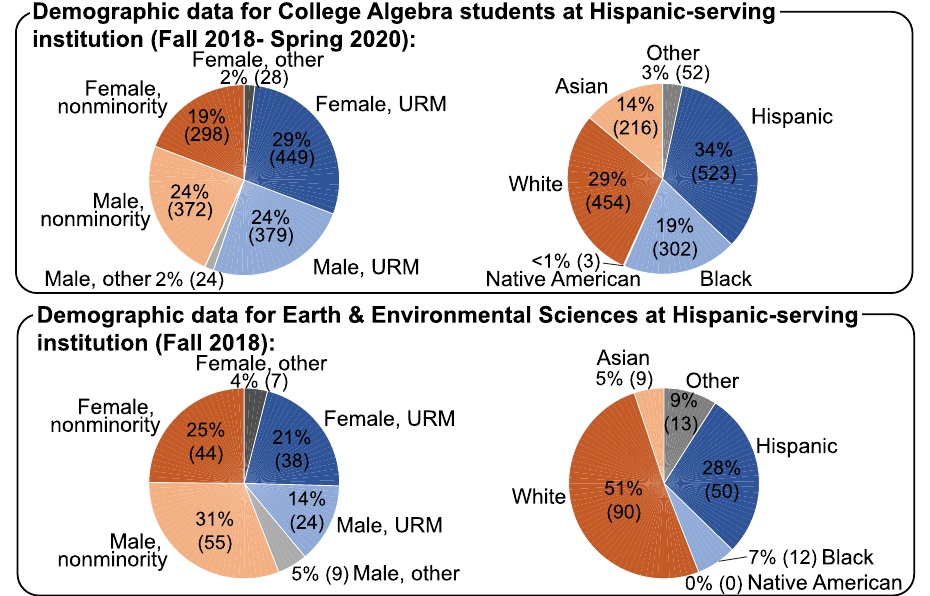
Fig. 1 Student demographics from 1550 surveys of students enrolled in College Algebra compared with those in Environmental and Earth Sciences at a large, urban, Hispanic-serving, R1 public university in the southwestern United States. In all graphs, underrepresented minority (URM) students identify as Hispanic, Black or African American, or Native American and are shown in shades of blue, overrepresented or non-URM students identify as White or Asian and are shown in shades of orange, and students who identi fi ed their ethnicity as “ other ” in